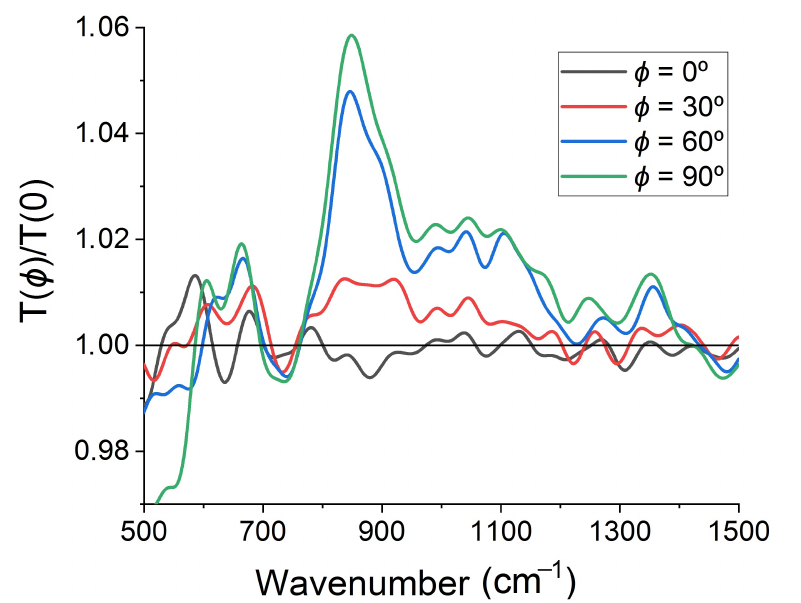
Figure 4. Ratio of the IR transmission spectra T ( φ ) / T ( 0 ◦ ) at polarization angles of φ = 0 ◦ ,30 ◦ ,60 ◦ , and 90 ◦ .